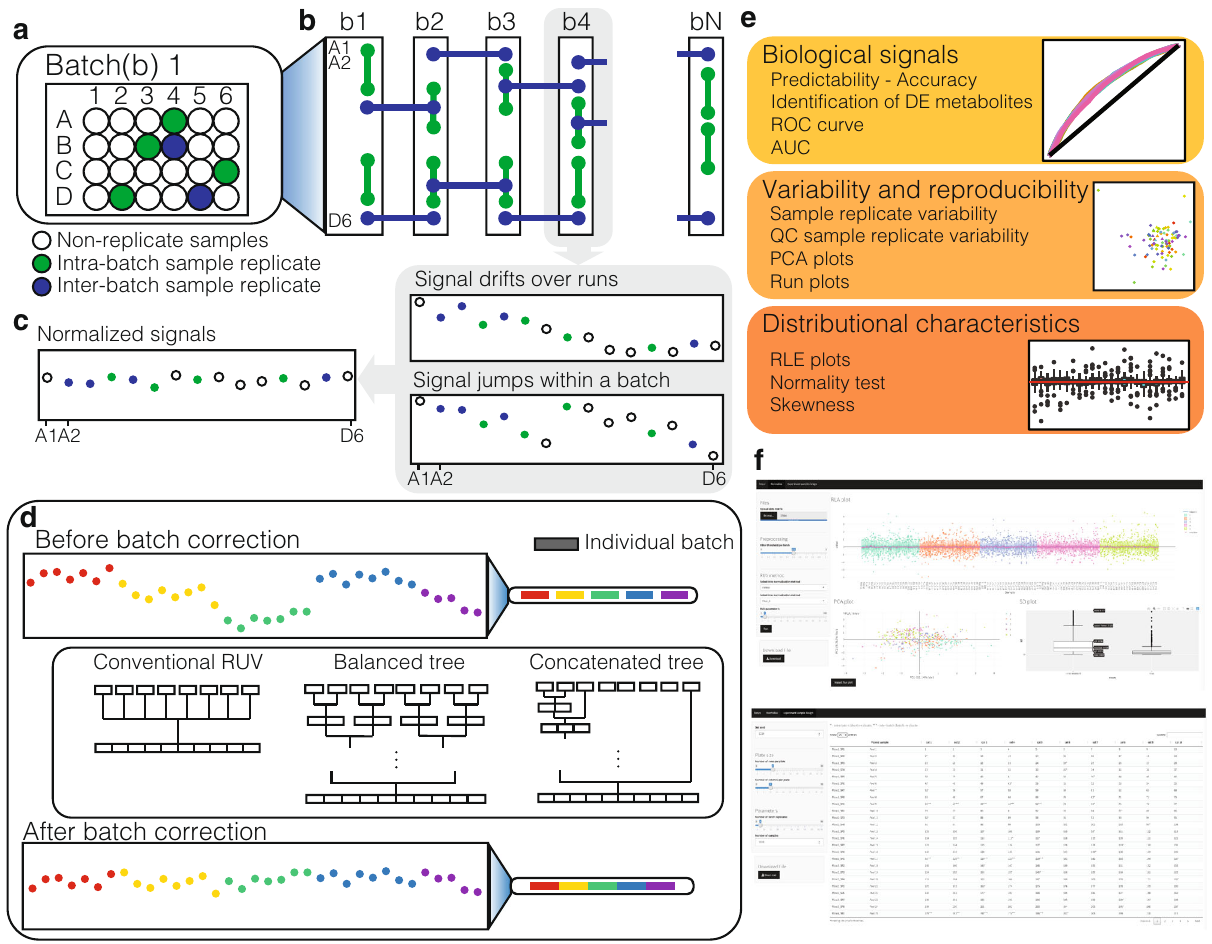
Fig. 1 Schematic overview of the hRUV pipeline. a A schematic illustration of the plasma sample arrangement for the experimental batch in an array format where intra-batch sample replicates (green circles) and inter-batch sample replicates (blue circles) are embedded. b A schematic illustration of overall sample replicate design and arrangements. c Continuing the colour scheme from b , two illustrative run plots requiring intra-batch correction, with signal drift and other variations illustrated in the grey boxes. d A demonstration of signal variation before and after inter-batch correction in hRUV. A common approach to inter-batch correction is illustrated as conventional RUV and the proposed hierarchical approaches are illustrated. e A list of evaluation criteria to assess hRUV performances grouped into categories of biological signals, variability and reproducibility and distributional characteristics. f A screenshot of the user-friendly shiny